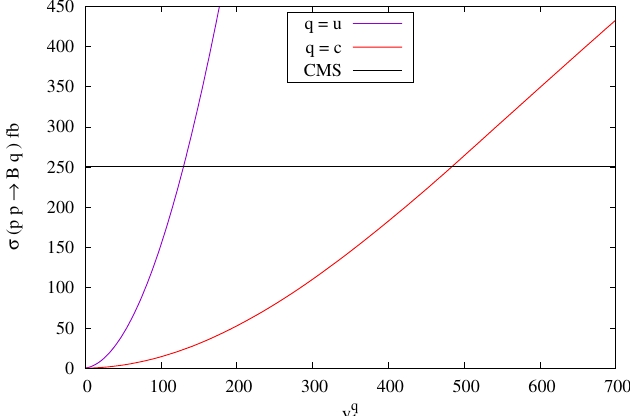
Figure 4 . Cross sections for single production of a bottom partner B in pp ! Bq , as a function of the y q (in GeV) for (cid:12)rst and second generation mixing. The mass is (cid:12)xed to 1000 GeV, and 1